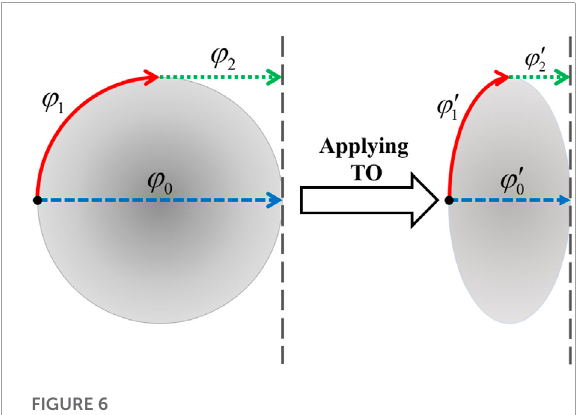
FIGURE 6 Schematics of the Luneburg lens before and after reshaping by